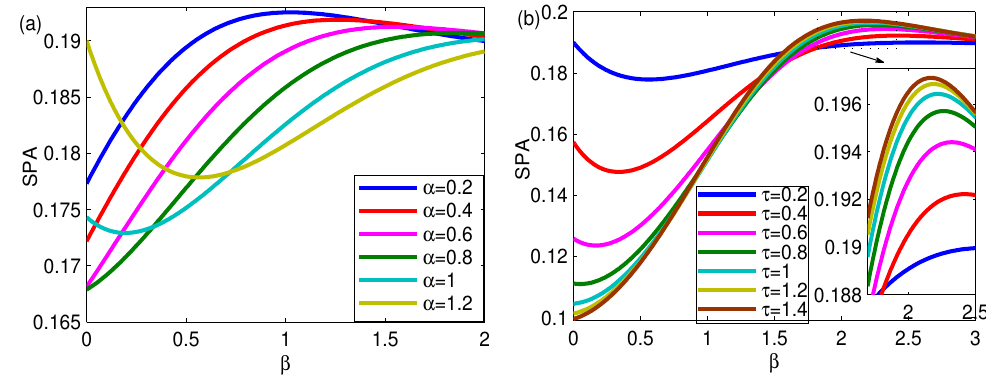
Figure 3. GSR behaviors of SPA( β ) in (36) different ( a ) α and ( b ) τ . ( a ) ¯ γ = 0.1, δ = 1.6, τ = 0.2, ω 0 = 1, Ω = 2, µ = ν = 0.8; ( b ) ¯ γ = 0.1, α = 1.2, δ = 1.6, ω 0 = 1, Ω = 2, µ = ν =